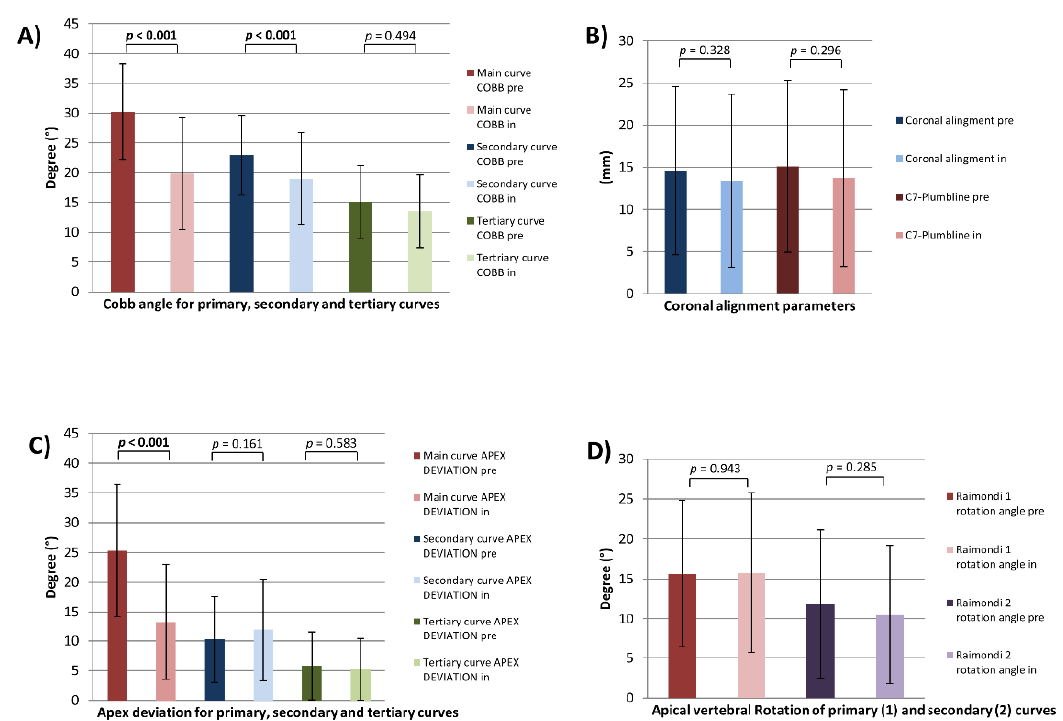
Figure 3. Coronal and axial plane parameters. Cobb angle ( A ), coronal alignment parameters ( B ), apex deviation ( C ) and apical vertebral rotation (AVR) ( D ) for all patients pre- and in-brace. Vertebral rotation was estimated using the Raimondi method. Raimondi 1 angle: AVR of primary curve, Raimondi 2 angle: AVR of secondary curve; p = statistical significance, p < 0.05.